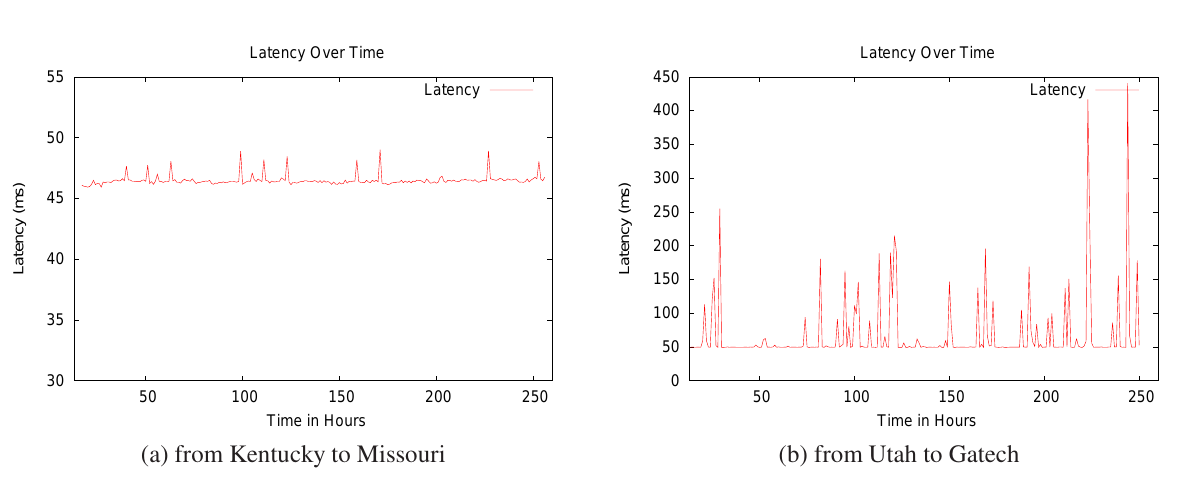
Figure 4. Latency of the links connecting two VMs from two different aggregates